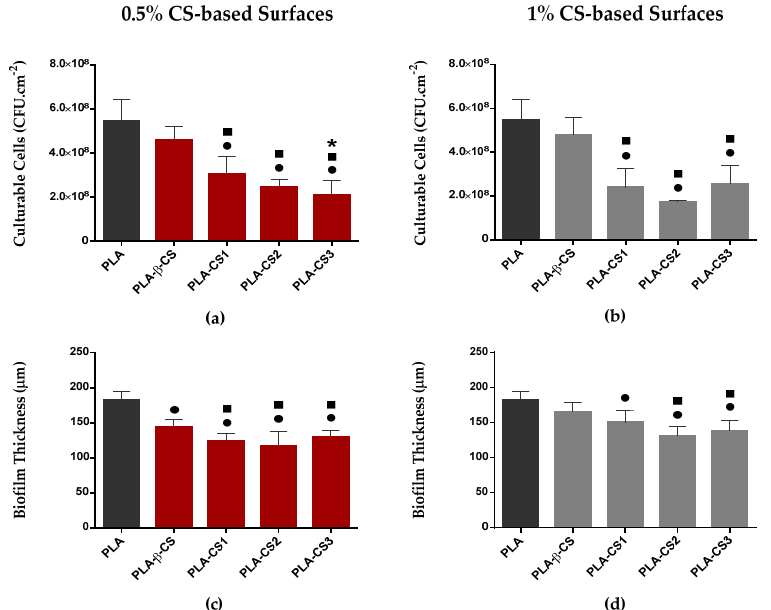
Figure 3. Culturable cells and thickness of C. marina biofilms formed on (cid:4) PLA, and (cid:4) 0.5% and (cid:4) 1% ( w / v ) CS-coated PLA surfaces (PLA- β -CS, PLA-CS1, PLA-CS2, and PLA-CS3) after 49 days. Differences between functionalized surfaces were evaluated using the non-parametric Mann–Whitney test and represented for p -values < 0.05 by • , (cid:4) , and * when compared to PLA, PLA- β -CS, and PLA- CS1,